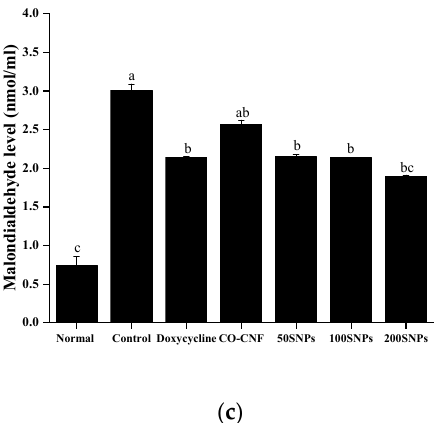
Figure 8. ( a ) nitric oxide production, ( b ) inhibition of nitroblue tetrazolium reduction, and ( c ) malondialdehyde level in nanoparticles treated lipopolysaccharide (LPS) stimulated human gingival fibroblast cells. The cells (1 × 10 4 cells/well) were pre-treated with 20 µL of samples (50 µg/mL) and 10 µL of LPS (1 µg/mL). Data are expressed as mean ± S.D. (n = 3). The letters (a-c) indicated the significant differences of the groups at p < 0.05 analyzed by the Tukey test. CO-CNF: κ -carrageenan